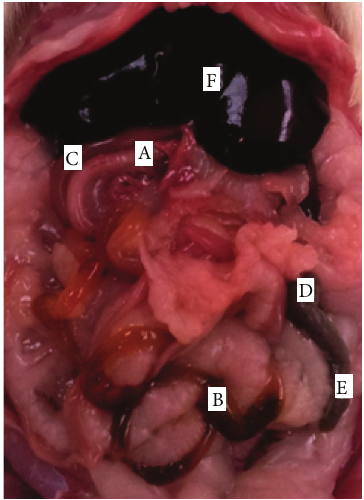
Figure 5: Abdominal cavity with intestine in rat, ventral view. A. duodenum , B. jejunum , C. colon , D. cecum , E. processus vermiformis , and F. hepar .